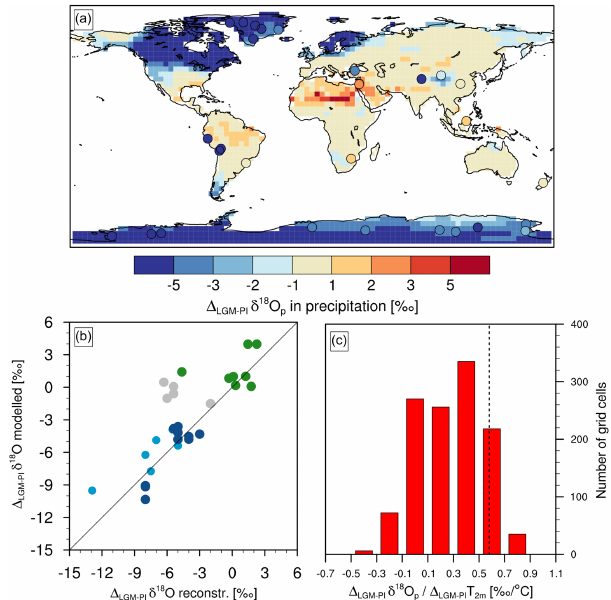
Figure 8. (a) Background pattern: simulated global pattern of an- nual mean δ 18 O p changes in precipitation between the LGM and PI climate. Reconstructed δ 18 O p in precipitation changes in ice cores (Table 1) and δ 18 O c in calcite of speleothems (Table 2) are shown as coloured symbols. (b) Comparison of reconstructed δ 18 O changes shown in panel (a) vs. the simulated LGM-PI δ 18 O changes at the same locations. Reconstructed δ 18 O p anomalies stem from the fol- lowing archives: Antarctica (dark blue), Greenland (light blue), and tropical ice cores (grey). For speleothems, reconstructed and simu- lated δ 18 O c changes are shown (green). The black line represents the 1:1 line indicating a perfect model fit. (c) Histogram of calcu- lated temporal LGM-PI δ 18 O p – T gradients for all grid cells with (i) an annual mean PI temperature below + 20 ◦ C and (ii) a simu- lated LGM-PI cooling of at least − 2 ◦ . The dashed line indicates the modelled PI spatial δ 18 O p – T gradient (0.58‰/ ◦